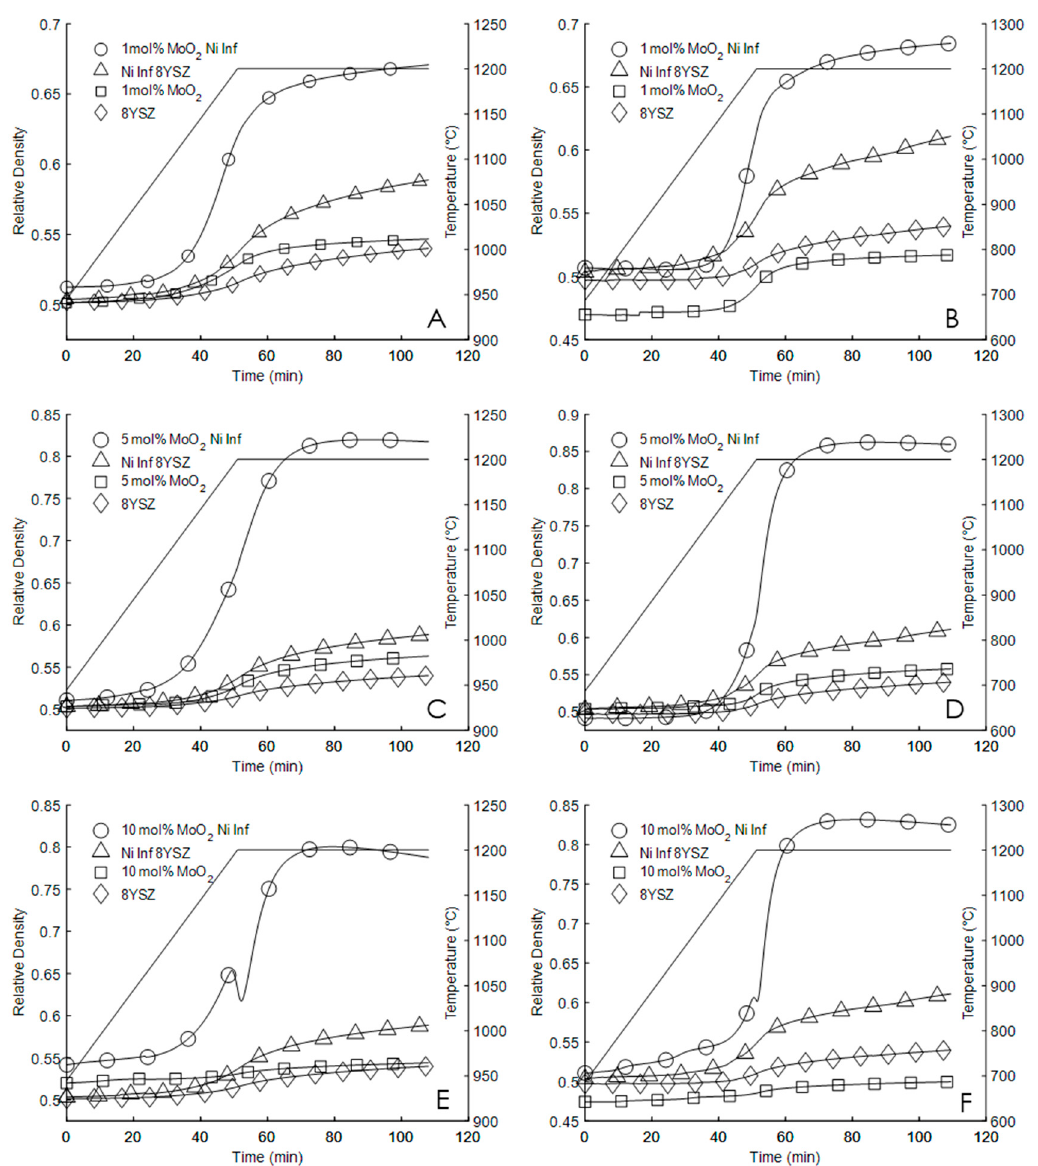
Figure 1. Sintering profiles of 8YSZ, Ni(NO 3 ) 2 infiltrated 8YSZ, 8YSZ with MoO 2 , and Ni(NO 3 ) 2 infiltrated 8YSZ with MoO 2 sintered up to and held at 1200 °C for one hour with heating rates of 5 °C infiltrated 8YSZ with MoO 2 sintered up to and held at 1200 ◦ C for one hour with heating rates of 5 ◦ C per minute ( A , C , and E ), and 10 °C per minute ( B , D , and F ) according to the temperature profile per minute ( A , C , E ), and 10 ◦ C per minute ( B , D , F ) according to the temperature profile indicated in indicated in each figure by the solid black line (-). From [32], with copyright permission each figure by the solid black line (-). From [32], with copyright